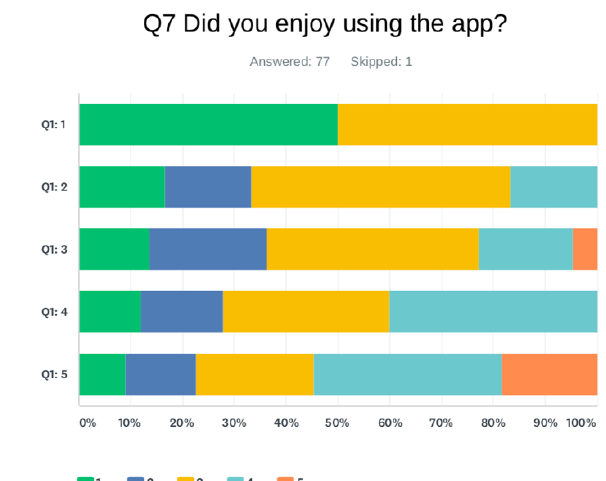
Figure 8. Question 7 split by scores to “Q1. How much experience do you have with writing overall, on a scale of 1-5, with 5 being the highest?”